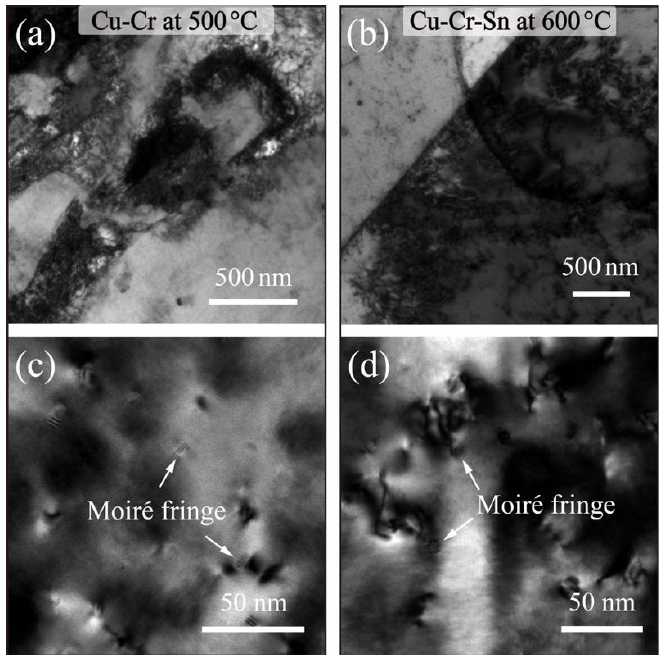
Figure 5. Bright-field images of softening behavior in ( a , c ) Cu-Cr alloy at 500 °C and ( b , d ) Cu-Cr-Sn alloy at 600 °C annealing for 60 min.